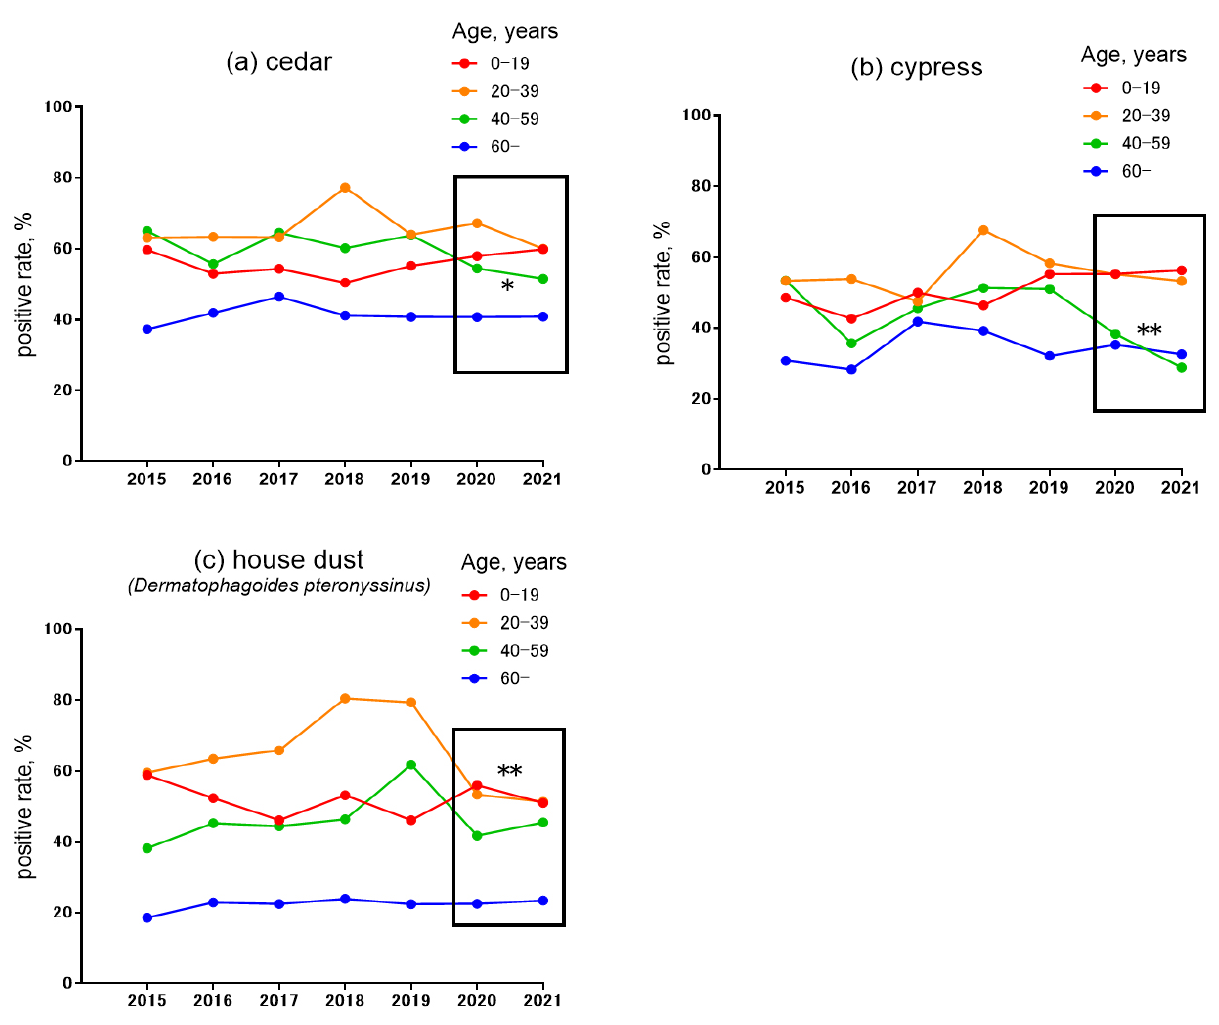
Figure 1. Changes in the positive antigen rate against ( a ) cedar, ( b ) cypress, and ( c ) house dust mites for each age group before and after the COVID-19 outbreak. * p < 0.05, ** p < 0.01, Fisher’s exact test.